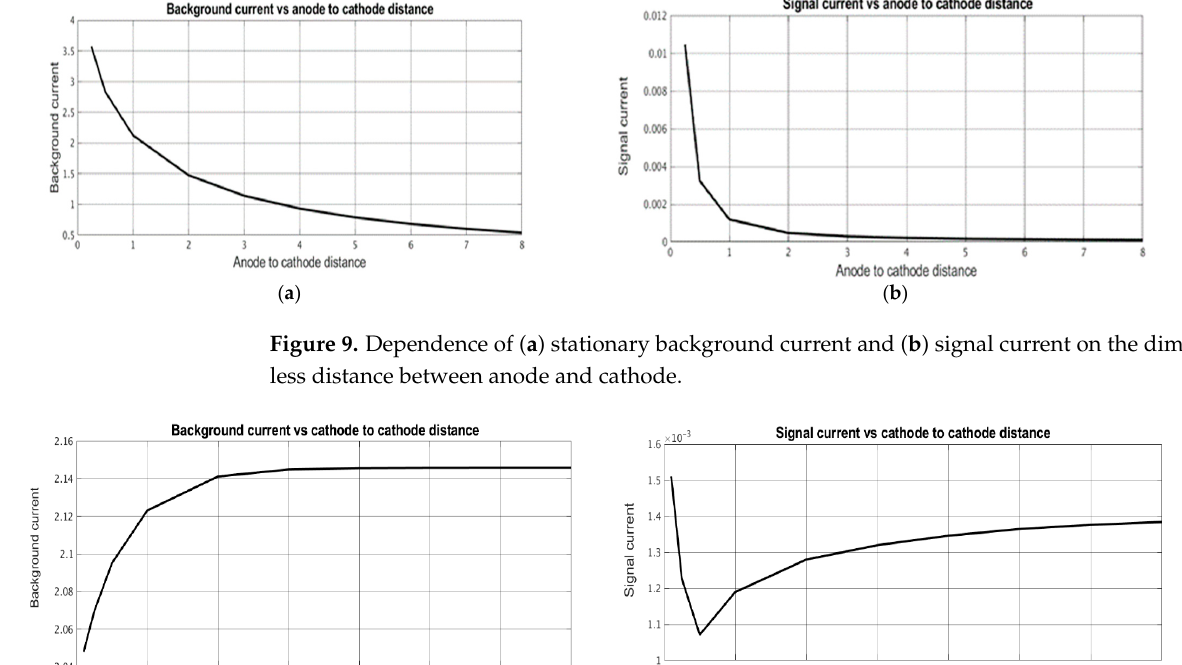
Figure 9. Dependence of ( a ) stationary background current and ( b ) signal current on the dimension- less distance between anode and cathode.